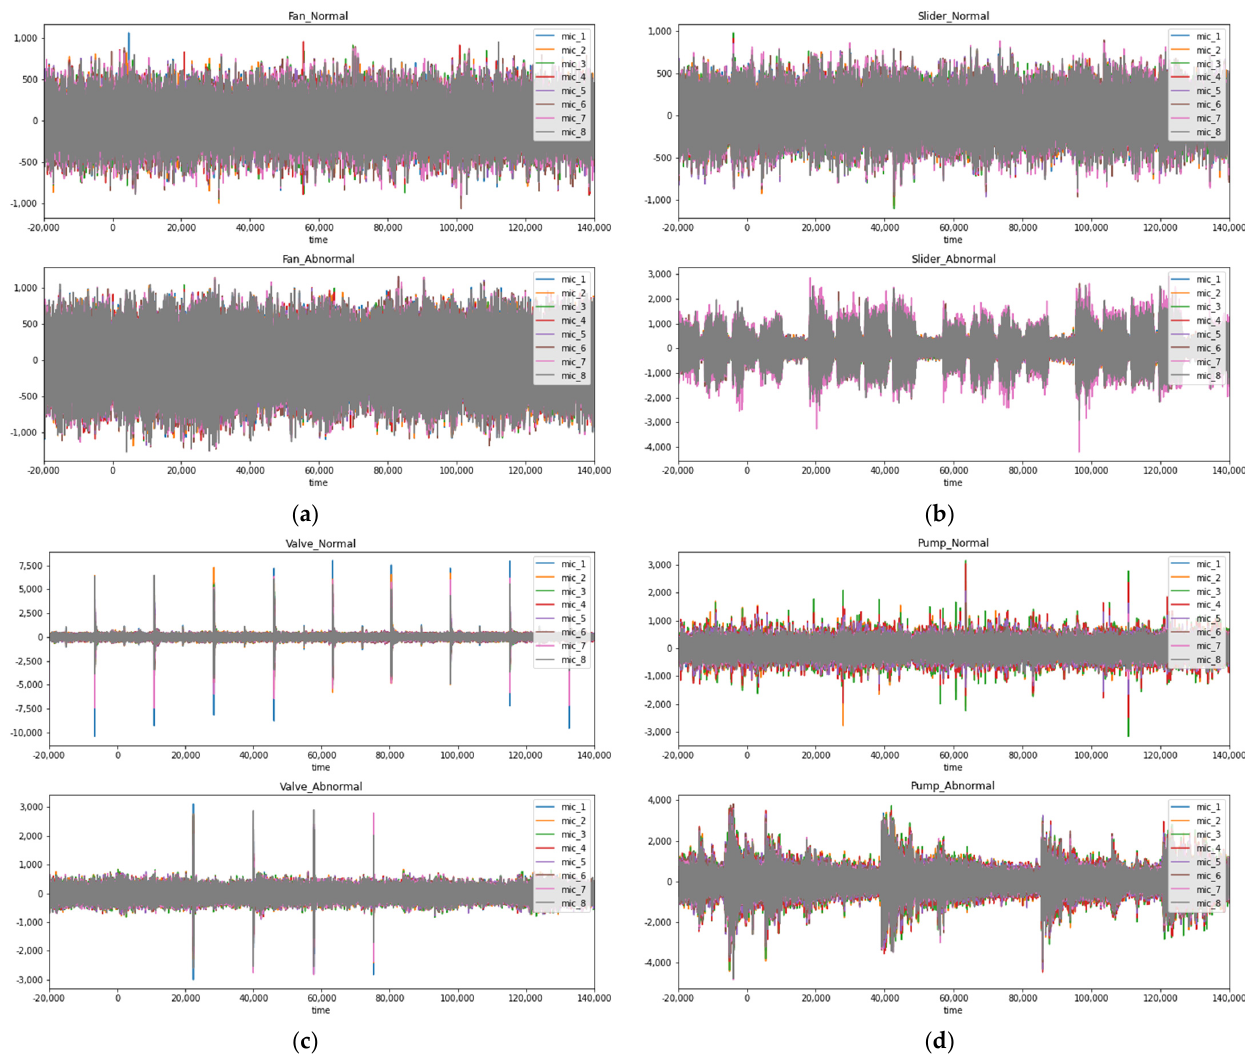
Figure 13. Visualizations of sound data for each device of the MIMII dataset: ( a ) normal and abnormal data for fan; ( b ) normal and abnormal data for slider; ( c ) normal and abnormal data for valve; ( d ) normal and abnormal data for pump.